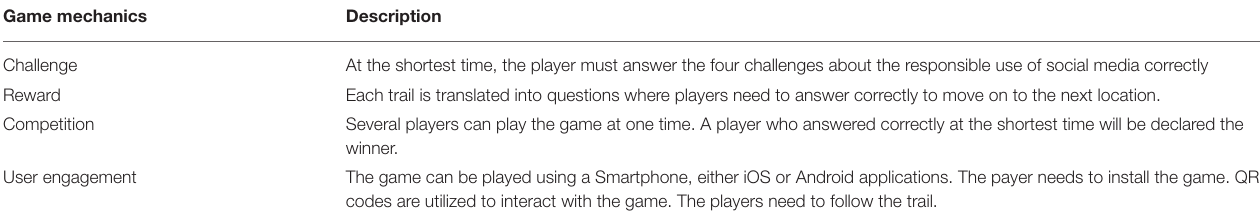
TABLE 5 | RUSM AR trail game